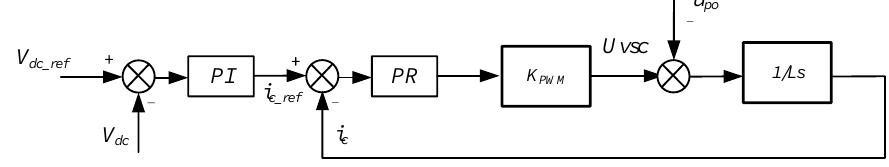
Figure 5. Closed Loop Control Block Diagram of VSC at Rectifier